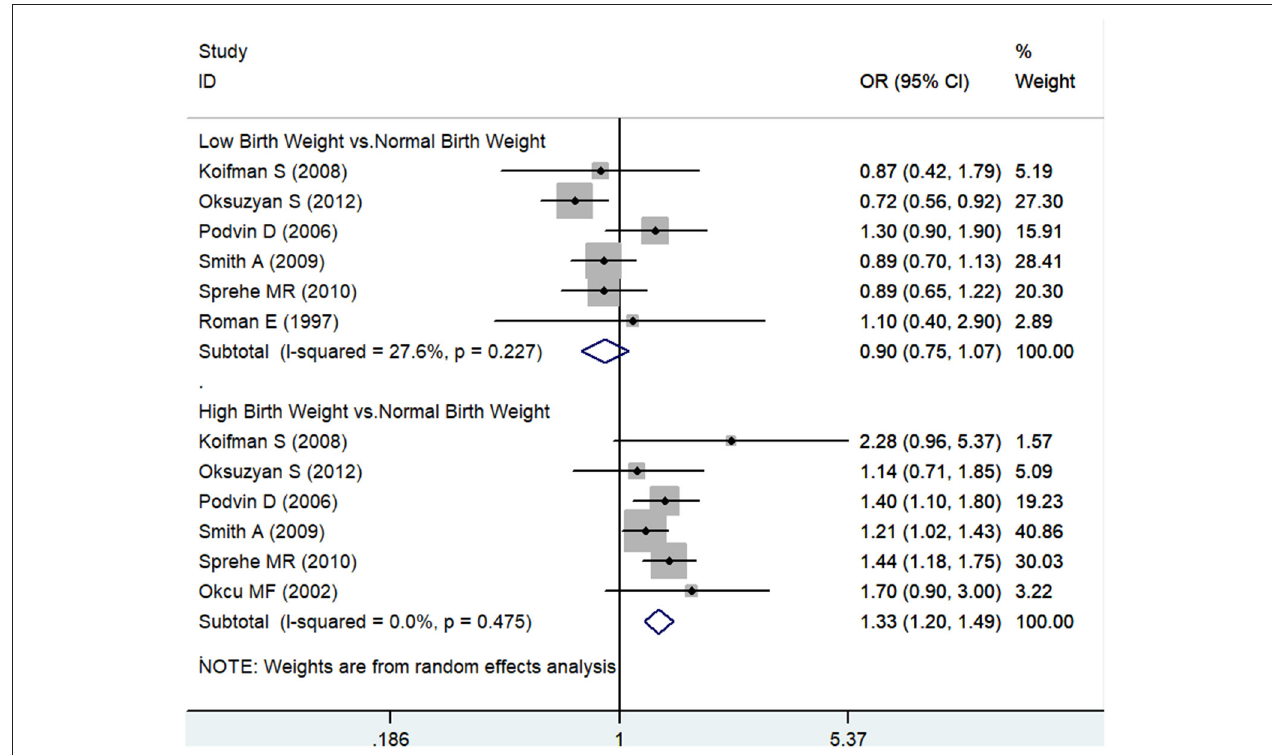
FIGURE 2 | The odds ratios for low birth weight, high birth weight, and total leukemia.